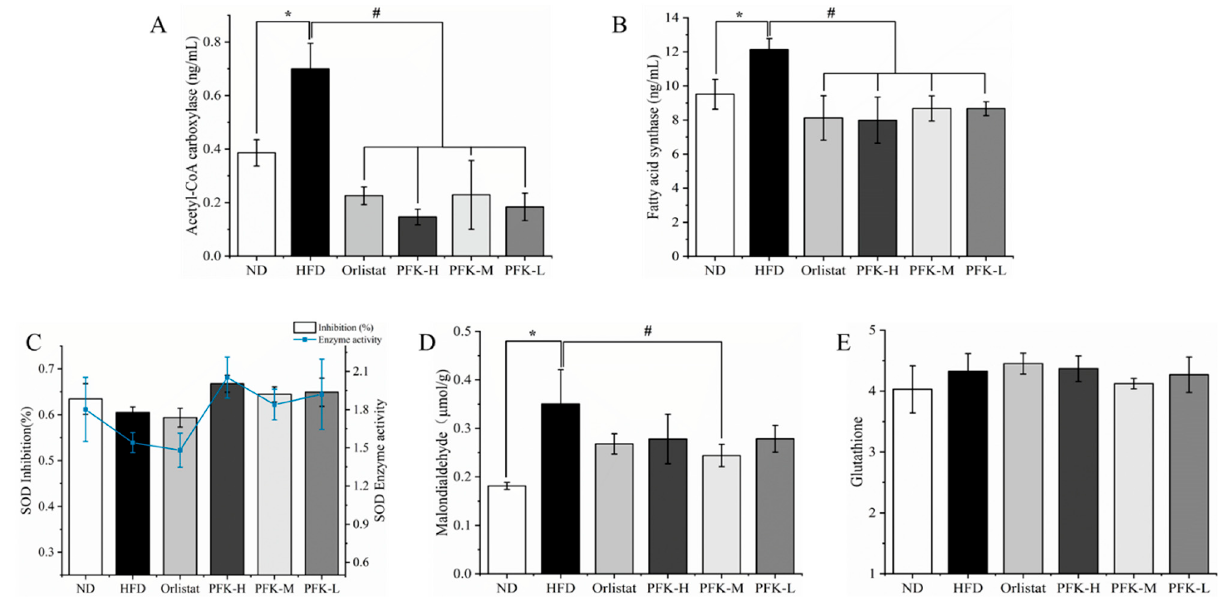
Figure 4. Effects of PFK on lipid metabolism and antioxidant activity. ( A ) ACC, ( B ) FAS, ( C ) SOD, ( D ) MDA, ( E ) GSH. ND group: normal diet + 0.5% CMC-Na; HFD group: high-fat diet + 0.5% CMC-Na; Orlistat group: high-fat diet + 20 mg/kg orlistat; PFK-H group: high-fat diet + 400 mg/kg krill